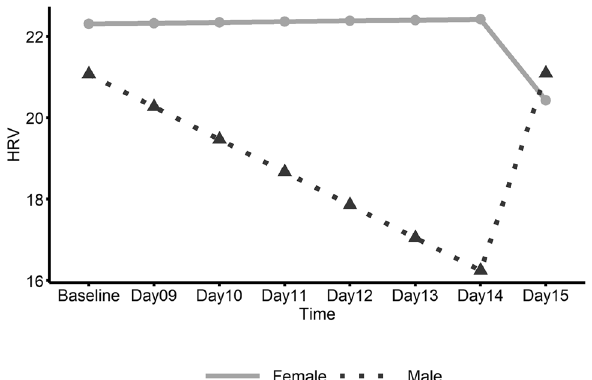
Figure 2. Linear trend of heart rate variability (HRV) by gender within the ME/CFS group. This graph shows daily heart rate variability (HRV) in ME/CFS participants from pre-exercise Baseline (Days 1–8) to follow-up (Days 9–15) with the solid line representing females and the dashed line representing males.